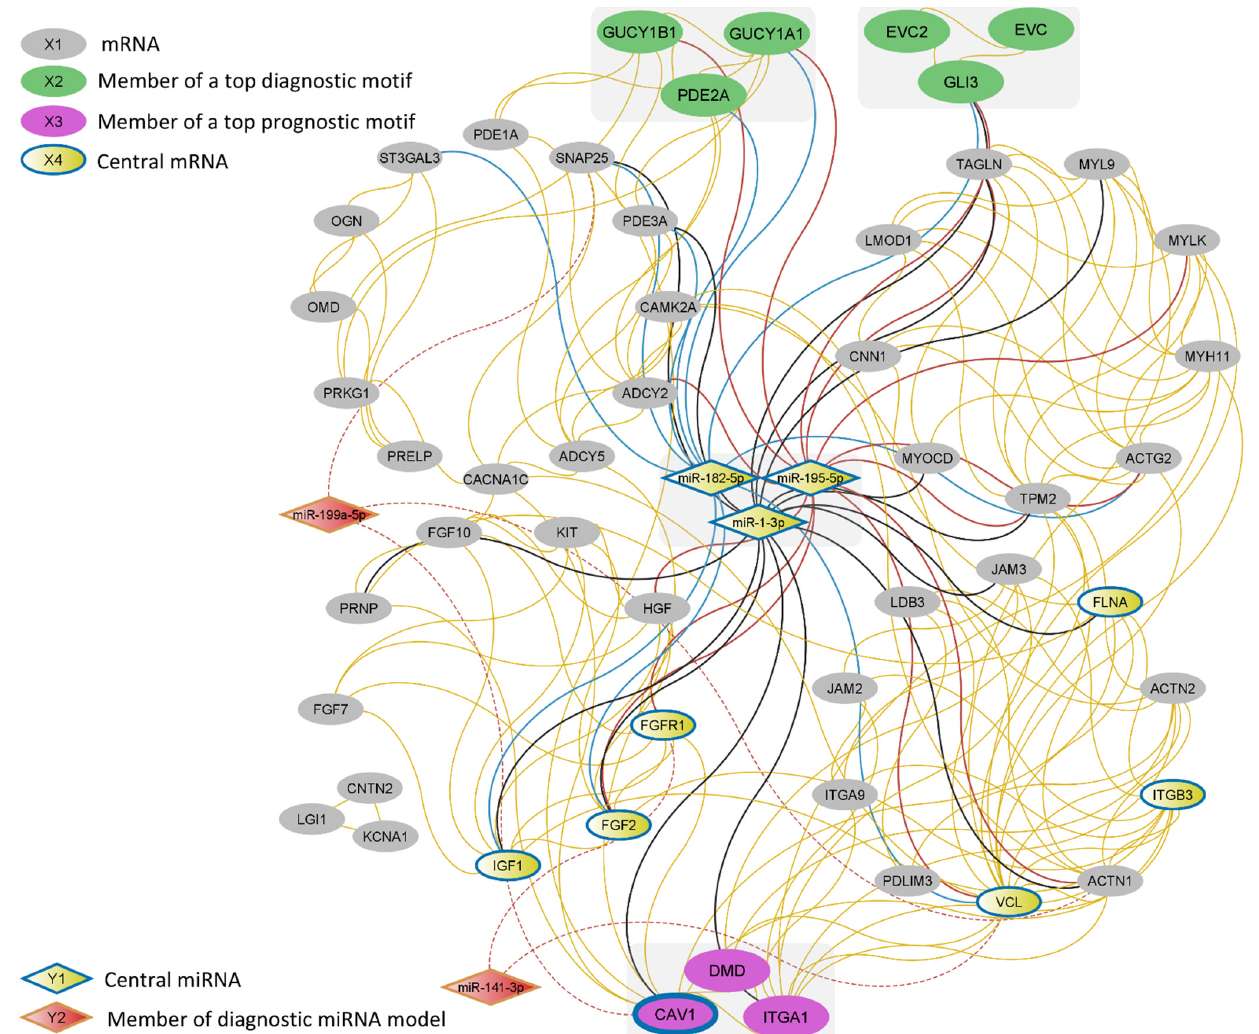
Figure 4. A network of top motifs from the 13 motif ranking scenarios and their miRNA regulators. The top 10 central RNAs based on the Latora closeness [31] are marked by blue margins. Yellow edges represent protein–protein interactions. MiR-182-5p, miR-195-5p, miR-1-3p interactions are represented with blue, red, and black solid lines, respectively. The interactions of the members of the miRNA diagnostic model are represented by dashed lines. To reduce complexity, only the 3 miRNAs that were among the top 10 central RNAs and the two miRNAs from the multi-candidate discriminatory miRNA combination are shown. The complete interaction data of the network consisting of 109 miRNAs, 51 mRNAs, and 435 edges are available in Supplementary Table S7.